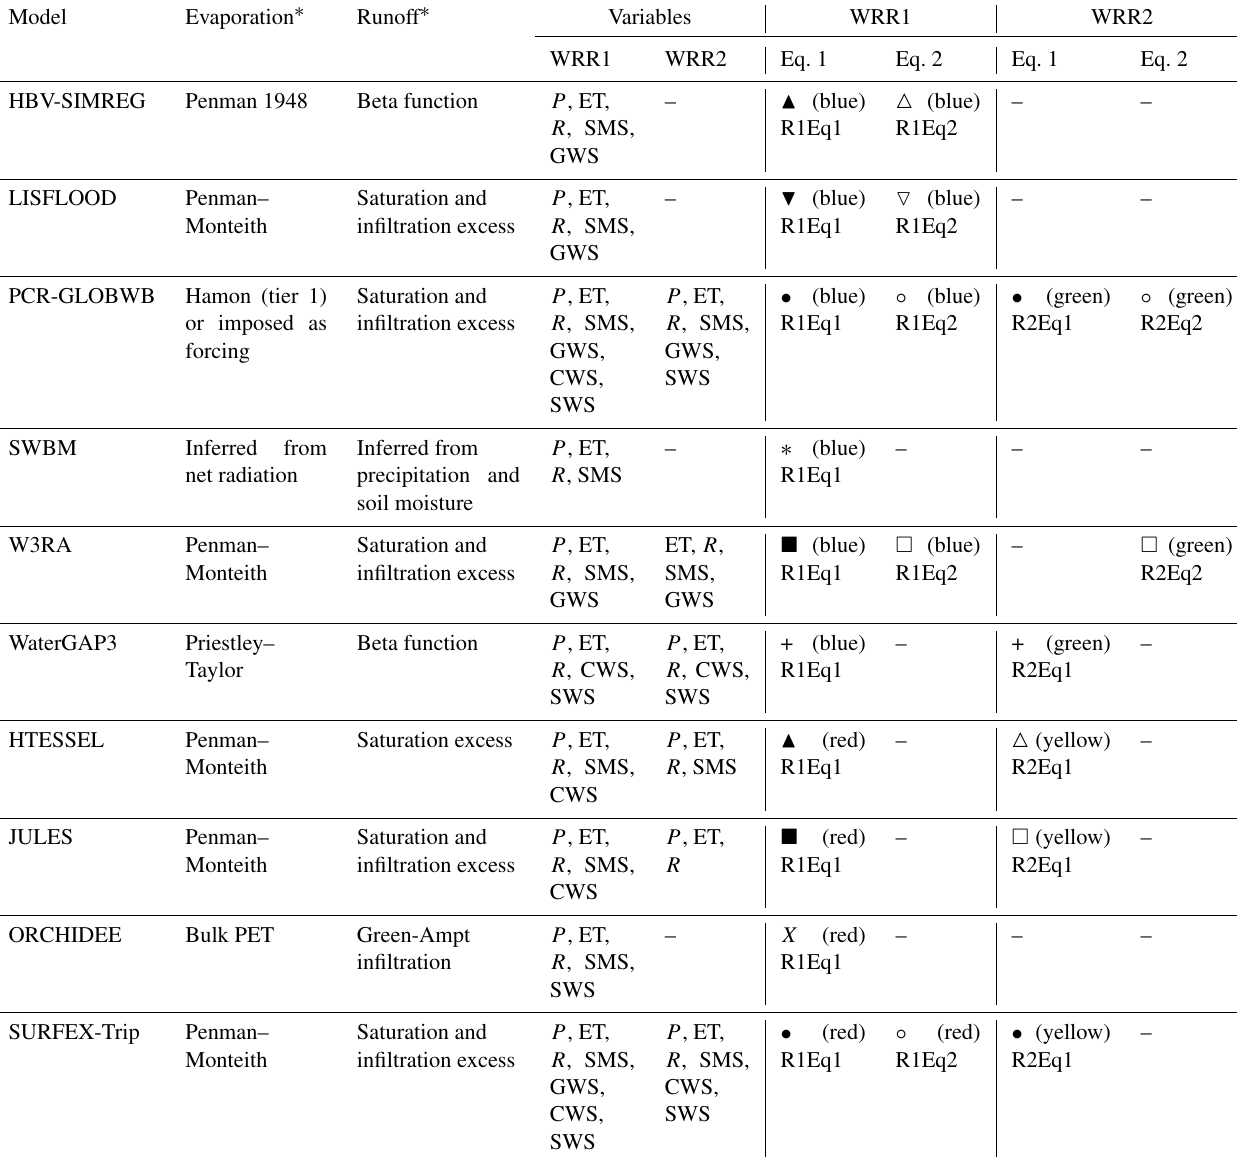
Table 2. Components used in the TWS change estimation for each model. The last four columns include the symbols and legends used to identify the model resolution and equation used to derive simulated TWS changes. These are used throughout the paper.